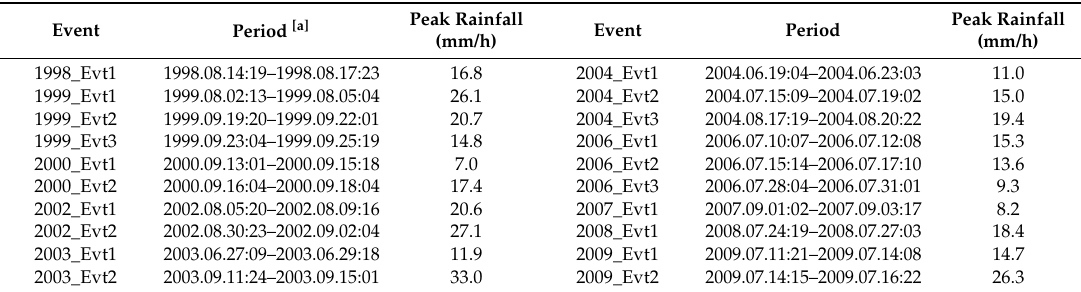
Table A1. Period and peak rainfall of the 20